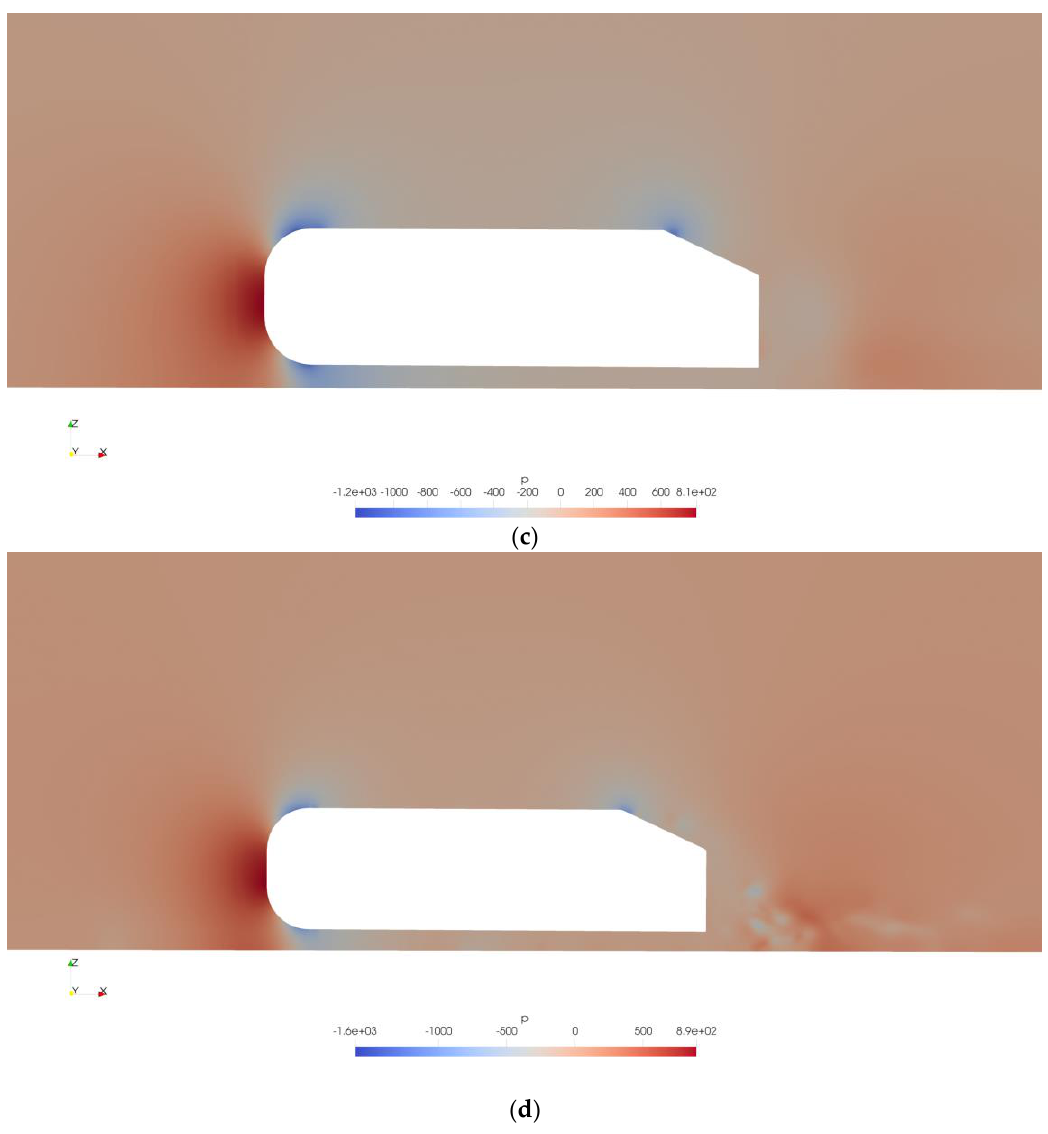
Figure 12. Pressure Contours for ( a ) RANS; ( b ) URANS; ( c ) VLES steady; ( d ) VLES simulations.